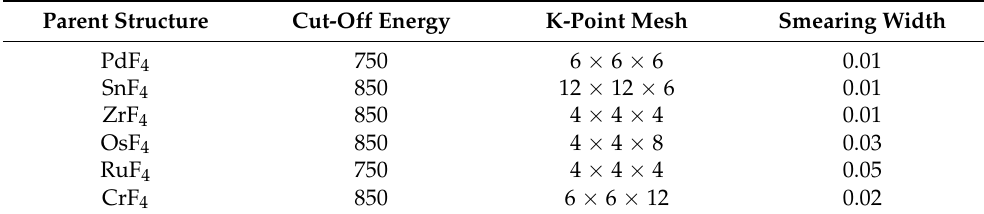
Table 1. Plane wave kinetic cut-off energy (in eV), K-point mesh and Gaussian smearing width (in eV) employed for all the considered parent